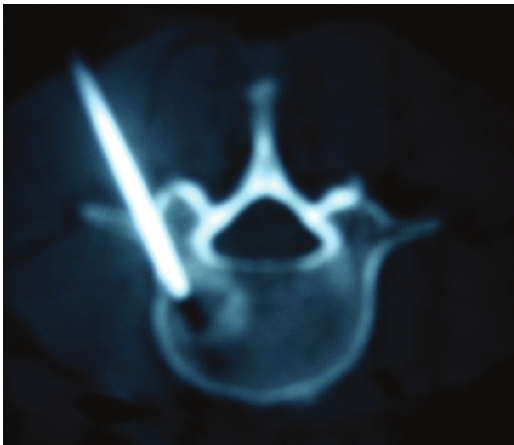
Figure 6 - Tomographic image of the minimally invasive transpedicular procedure in the fourth lumbar